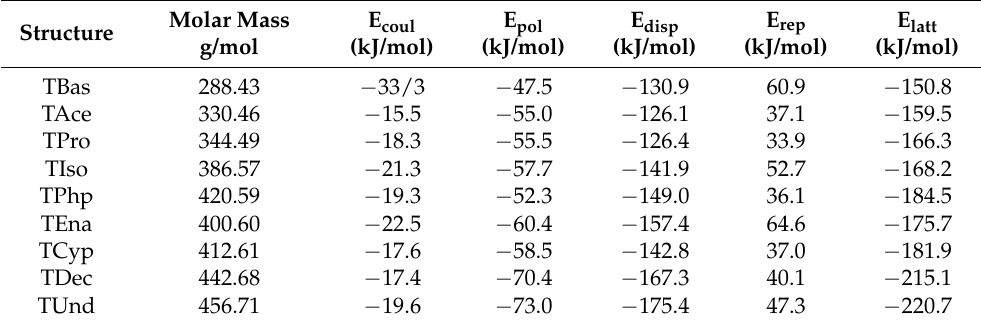
Table 2. Crystal lattice energies